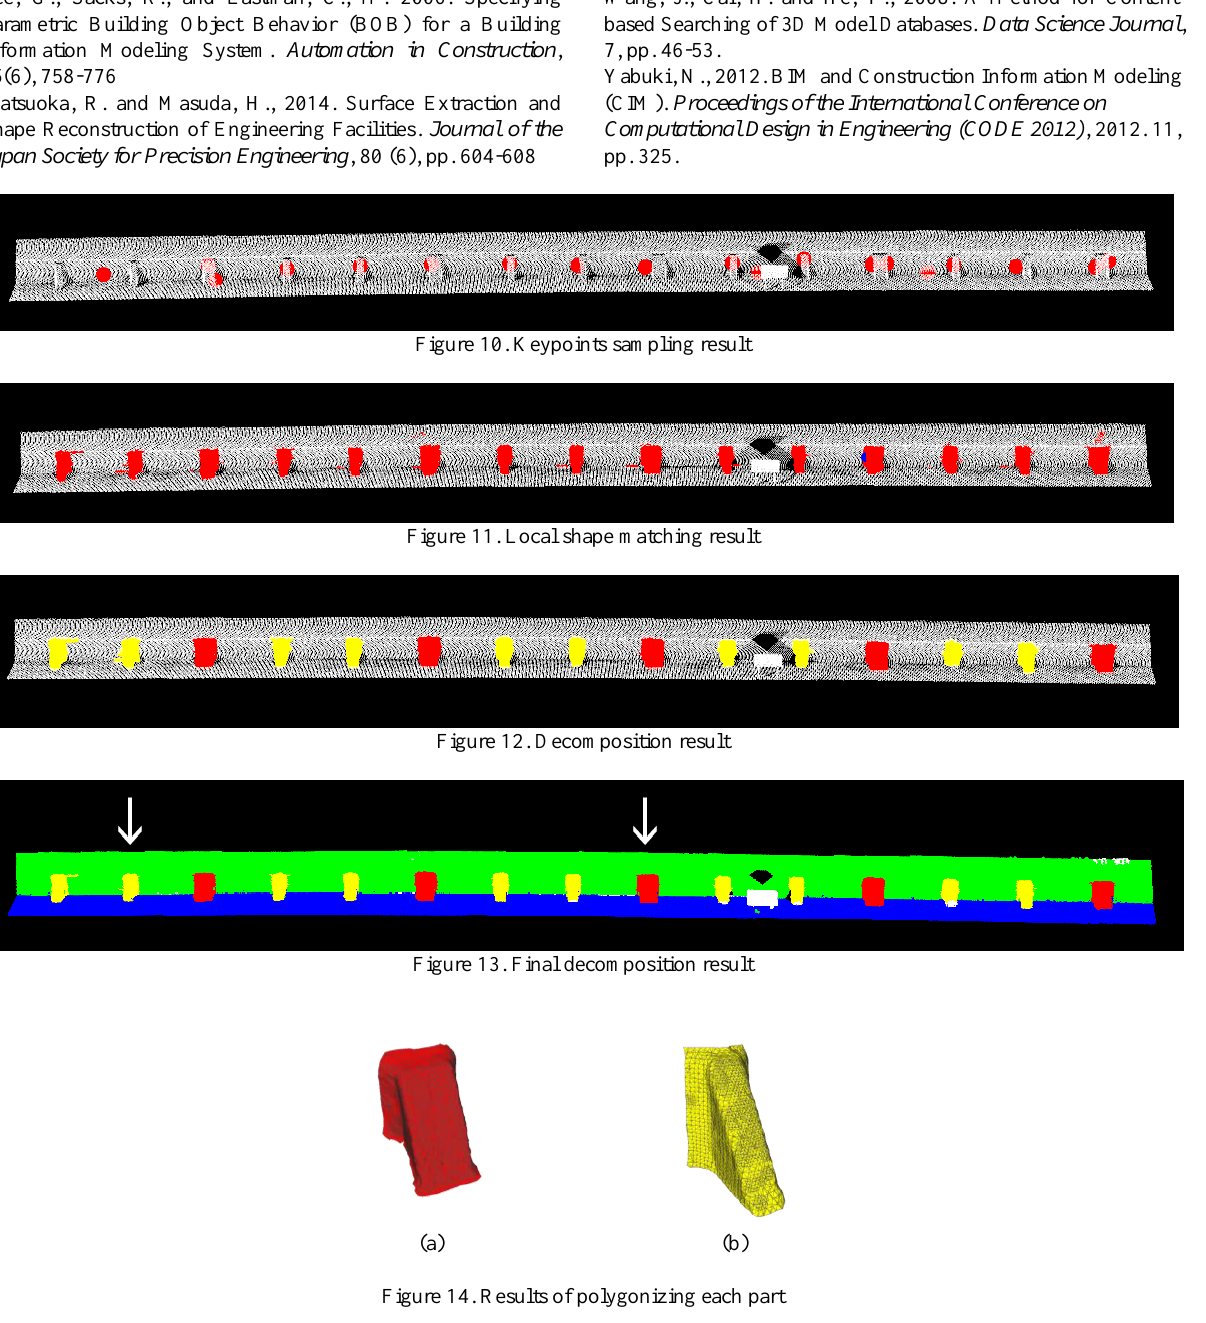
Figure 14. Results of polygonizing each part